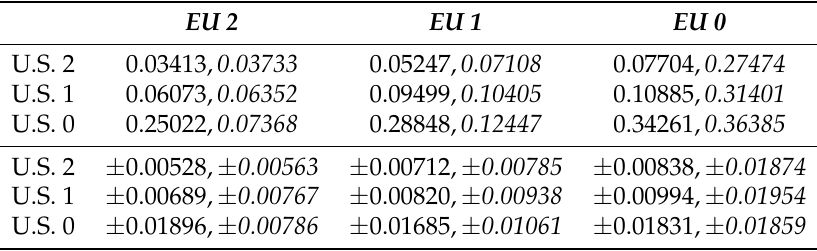
Table 2. Risk matrix for both players for each combination of strategies. The risks are the average cumulative risk of losing an asset over the course of 150 years. We show 95% confidence intervals in the lower